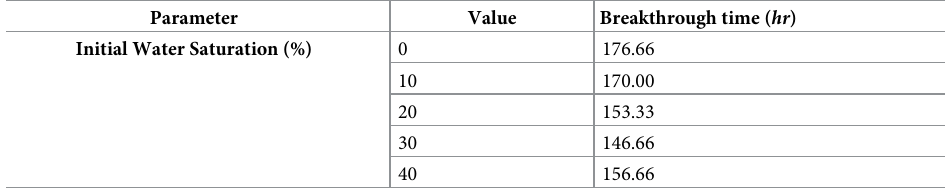
Table 8. Calculated breakthrough times for the oil viscosity and density sensitivity